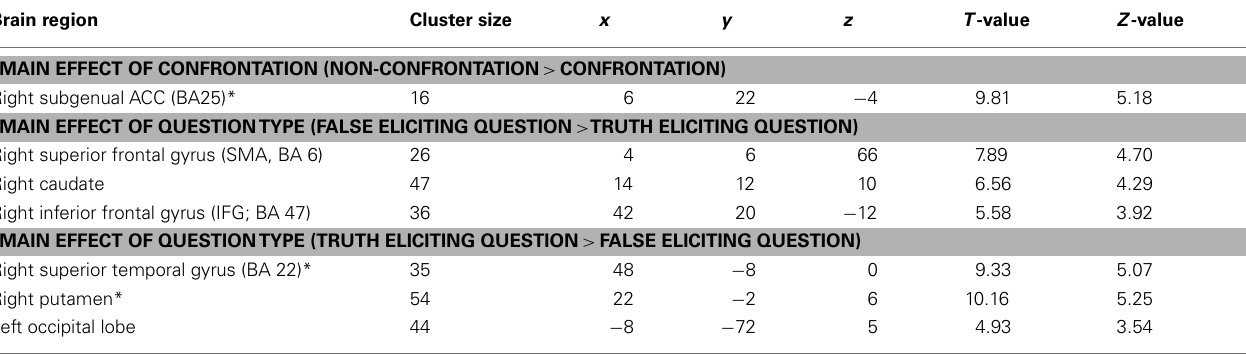
Table 1 | Brain regions showing activation in